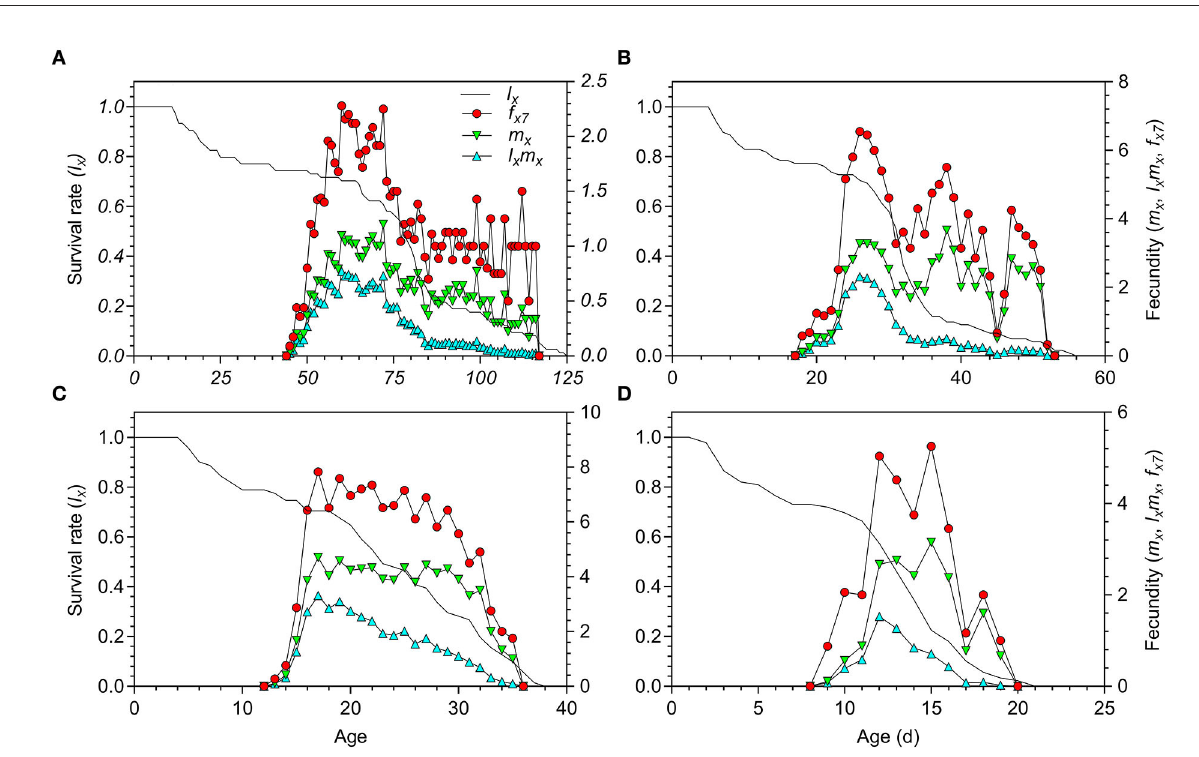
than that at 33 ◦ C (17.87 eggs/female). However, the number of eggs laid per female per day ( f ) at 27 ◦ C (5.28 eggs) was obviously larger than those at 23.5 ◦ C (3.57 eggs), 33 ◦ C (2.93 eggs), and 18.5 ◦ C (1.32 eggs). Among the tested temperatures, the female age-specific fecundity ( f x 7 ) first increased rapidly, peaked, and then decreased (Figure 2). The peak f x 7 of O. strigicollis was 7.83 eggs/female at 27 ◦ C, which was higher than that at 23.5 ◦ C (6.55 eggs/female), 33 ◦ C (5.25 eggs/female), and 18.5 ◦ C (2.28 eggs/female). Fecundity ( m x ) and net maternity ( l x m x ) are plotted in Figure 2.